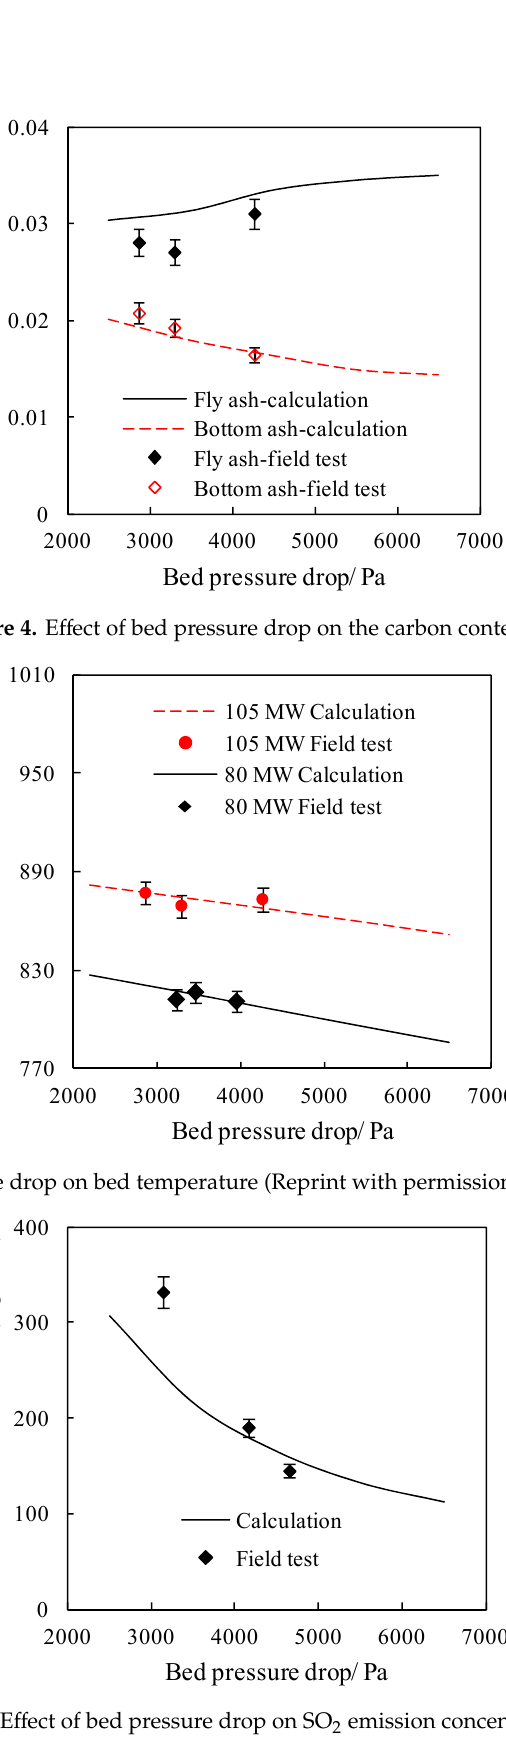
Figure 6. E ff ect of bed pressure drop on SO 2 emission Figure 6. Effect of bed pressure drop on SO 2 emission concentration.